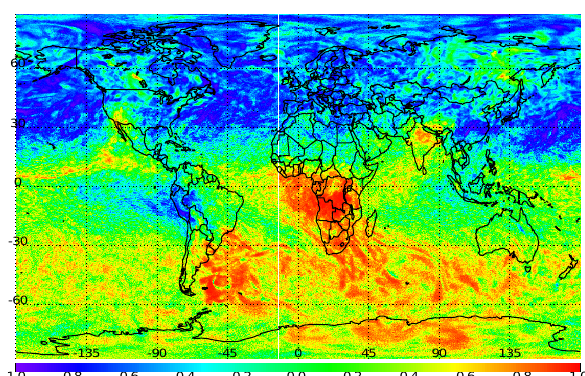
Fig. 3. Model error correlation coefficients between CO 2 and CO columns calculated with the paired-forecast method for July 2008 at 1/2 ◦ × 2/3 ◦ resolution. No averaging kernels were applied. Results can be compared to the July panels of Fig.